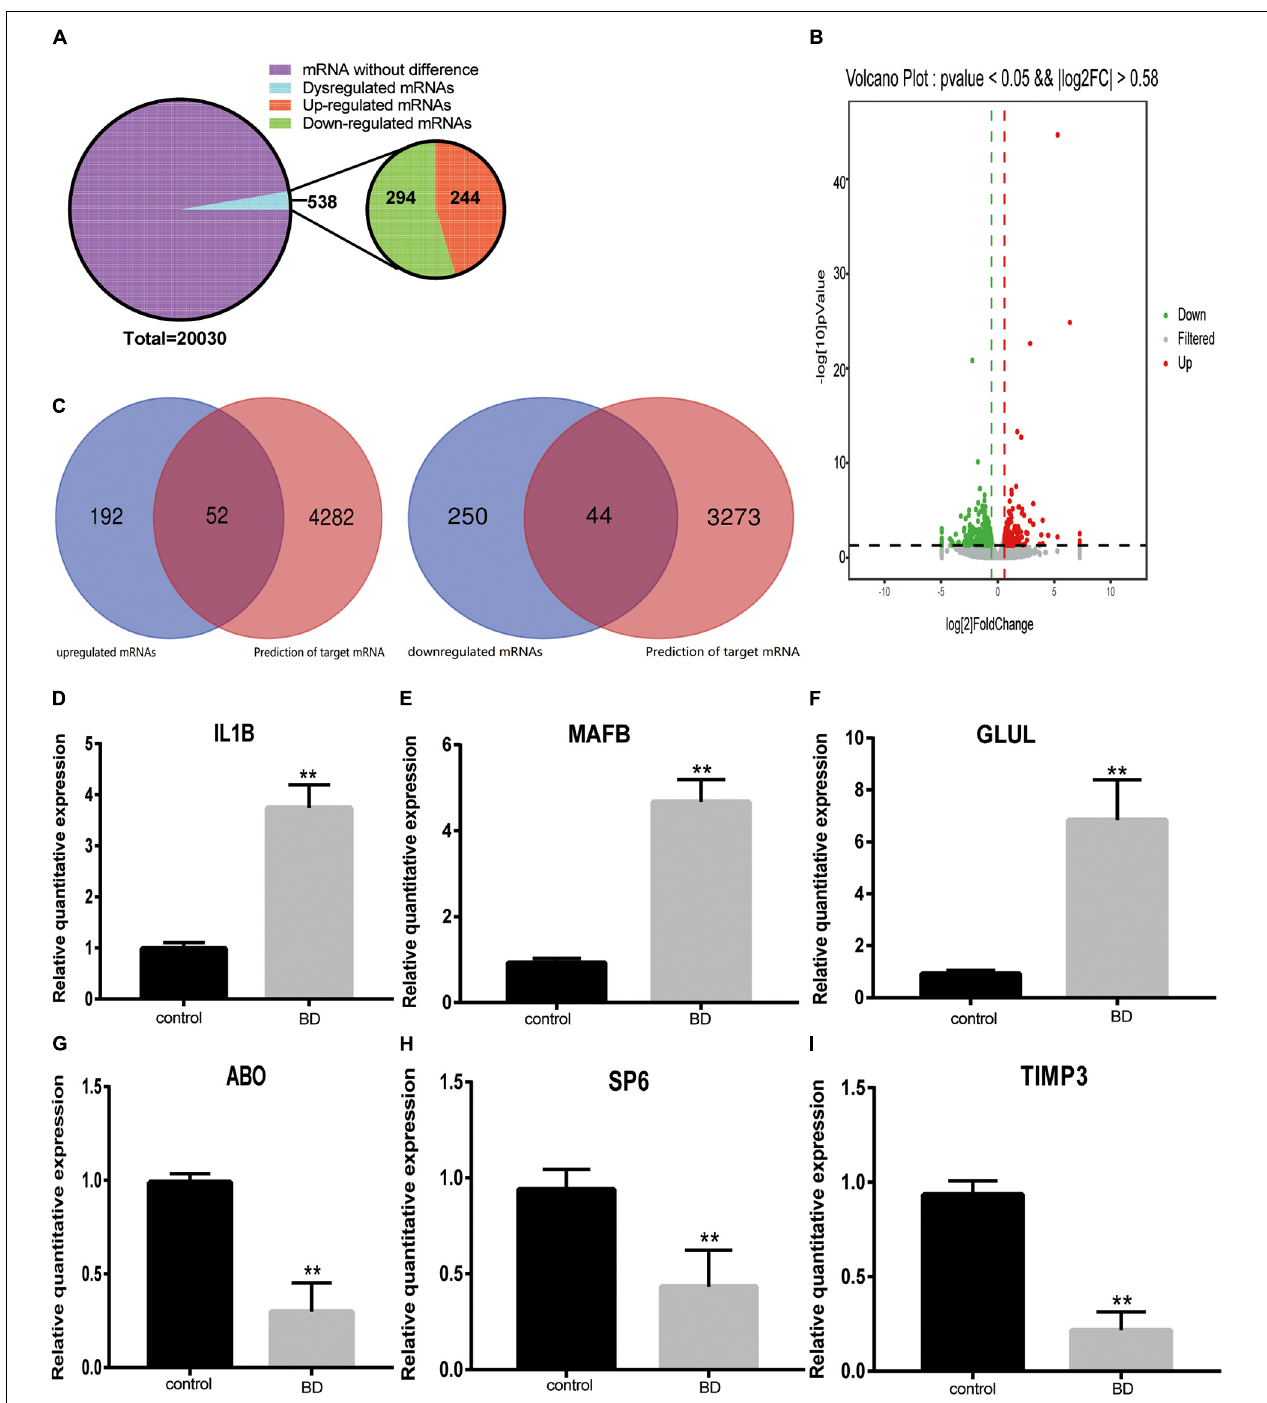
FIGURE 5 | The mRNAs expression pattern and validation of DE-mRNA expression. (A) Pie chart of mRNAs expression classification. All 20,030 mRNAs were detected in silicon. A total of 538 mRNAs were dysregulated between two groups, including 244 upregulated and 294 downregulated circRNAs. (B) Volcano plot of mRNAs. Gray dots represent these mRNAs that were not considerably differentially expressed. Green and red dots indicate significantly downregulated and upregulated DE-RNAs, respectively. The thresholds were a | log2FC| ≥ 0.58 and P -value ≤ 0.05. (C) Venn diagram of the intersection of sequenced mRNAs and predicted mRNAs. The number of overlapping mRNAs between the upregulated DE-mRNAs determined by RNA-seq and the mRNAs predicted according to the top 10 upregulated circRNAs was 52. The number of overlapping mRNAs between the downregulated DE-mRNAs determined by RNA-seq and the mRNAs predicted according to the top 10 downregulated circRNAs was 44. (D–I) qRT-PCR was used to validate six mRNAs in the two groups. Three upregulated DE-mRNAs: IL1B (D) , MAFB (E) and GLUL (F) . Three downregulated DE-mRNAs: ABO (G) , SP6 (H) and TIMP3 (I) . **Indicate significant differences.